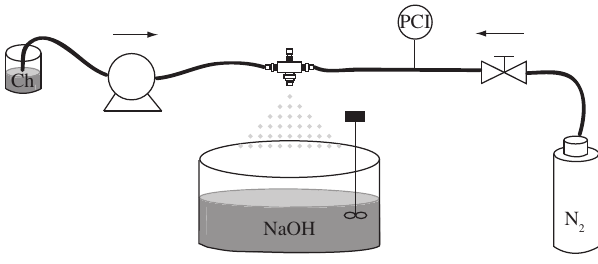
Figure 3. Spraying and coagulation process